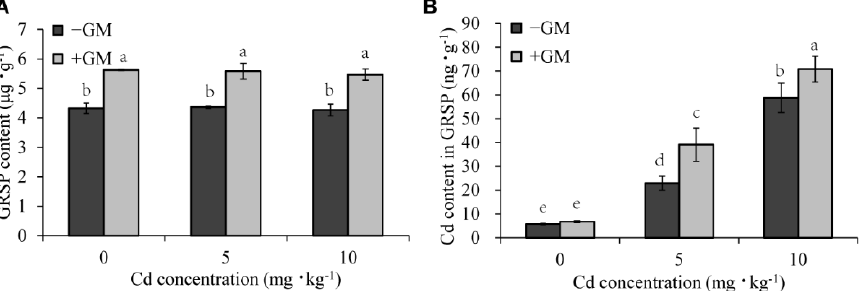
Figure 2. Changes in the content of GRSP secreted by AMF ( A ) and the content of Cd in GRSP ( B ) under different Cd concentrations. Values are the means ± standard deviation (SD) ( n = 3). Different letters in the same column indicate statistically significant differences ( p < 0.05).